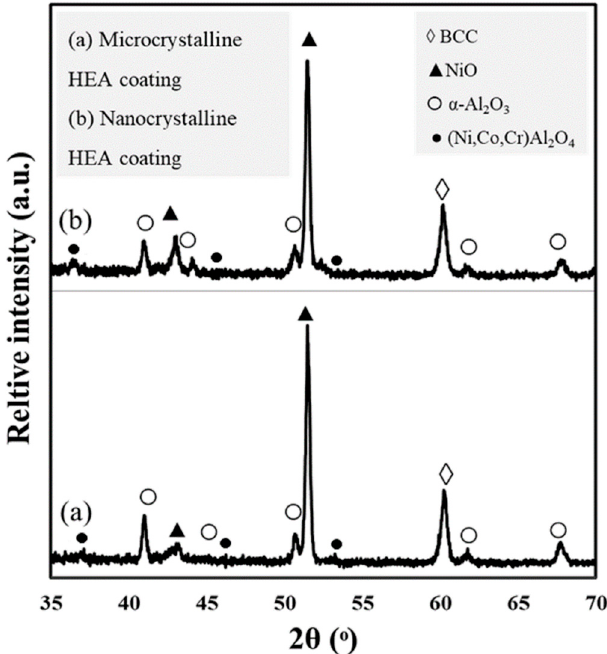
Figure 6. XRD patterns for AlCrFeCoNi HEA coating after 50 cycles of oxidation at 1100 °C: ( a ) microcrystalline coating and ( b ) nanocrystalline coating.